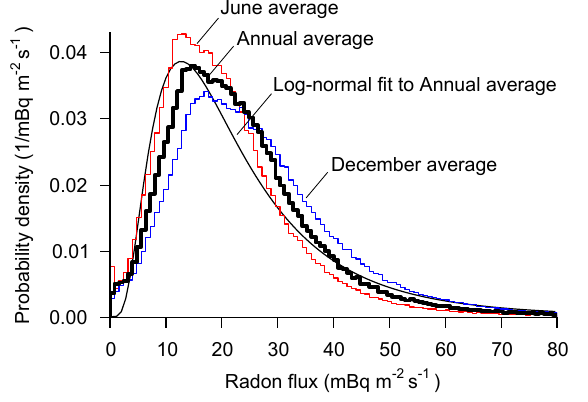
Fig. 9. Mean radon flux density versus